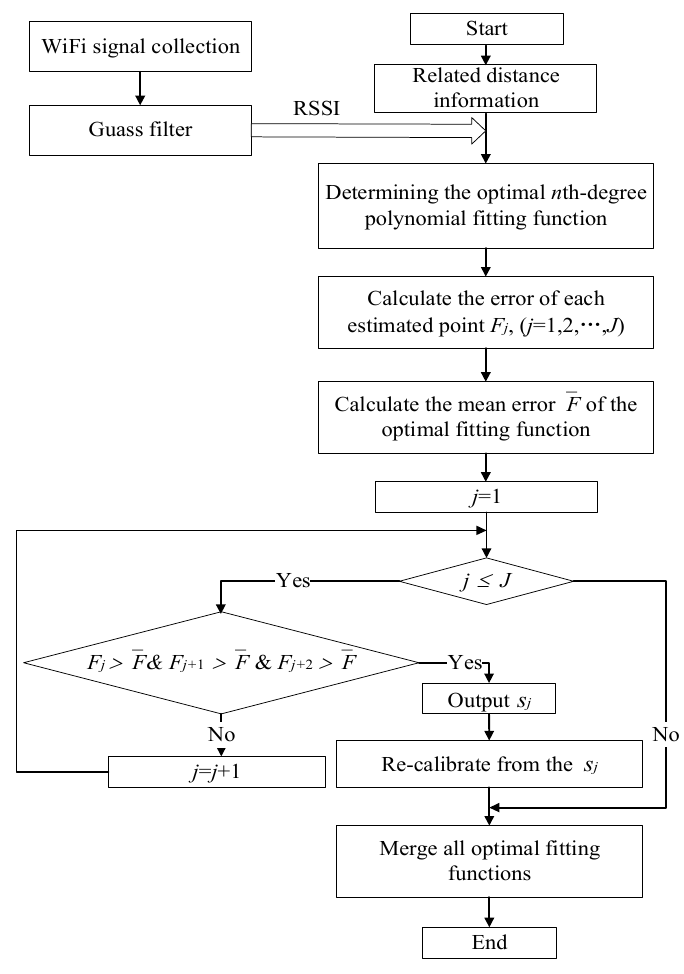
Figure 2. Flow chart of piecewise polynomial regression model (PPRM) algorithm.